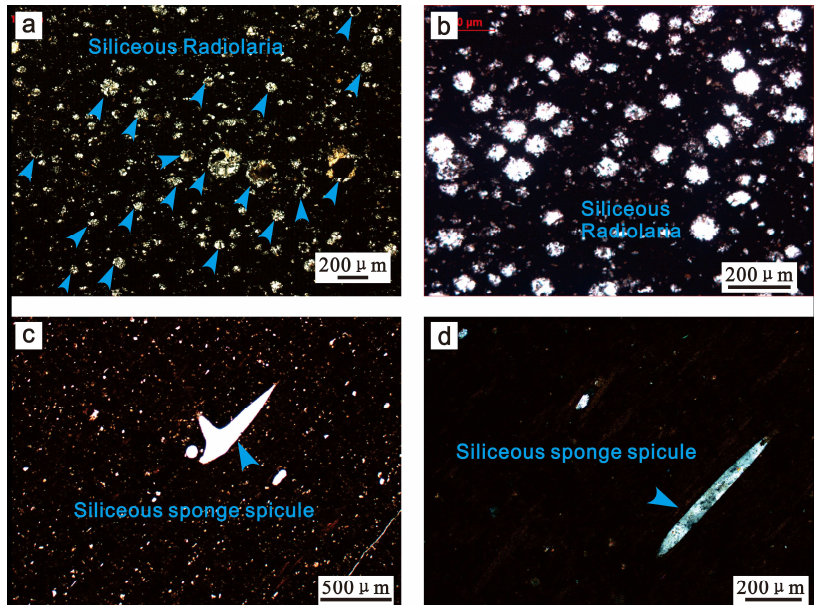
Figure 4. Correlation of quartz with clay + feldspar and TOC in the Wufeng and Longmaxi Formations of the Upper Yangtze region. ( a ) Correlation of quartz with clay + feldspar; ( b ) Correlation of quartz with TOC.